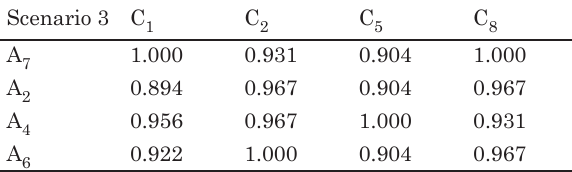
Table 12. Weighted and normalized decision-making matrix for the multiplication part (third scenario)